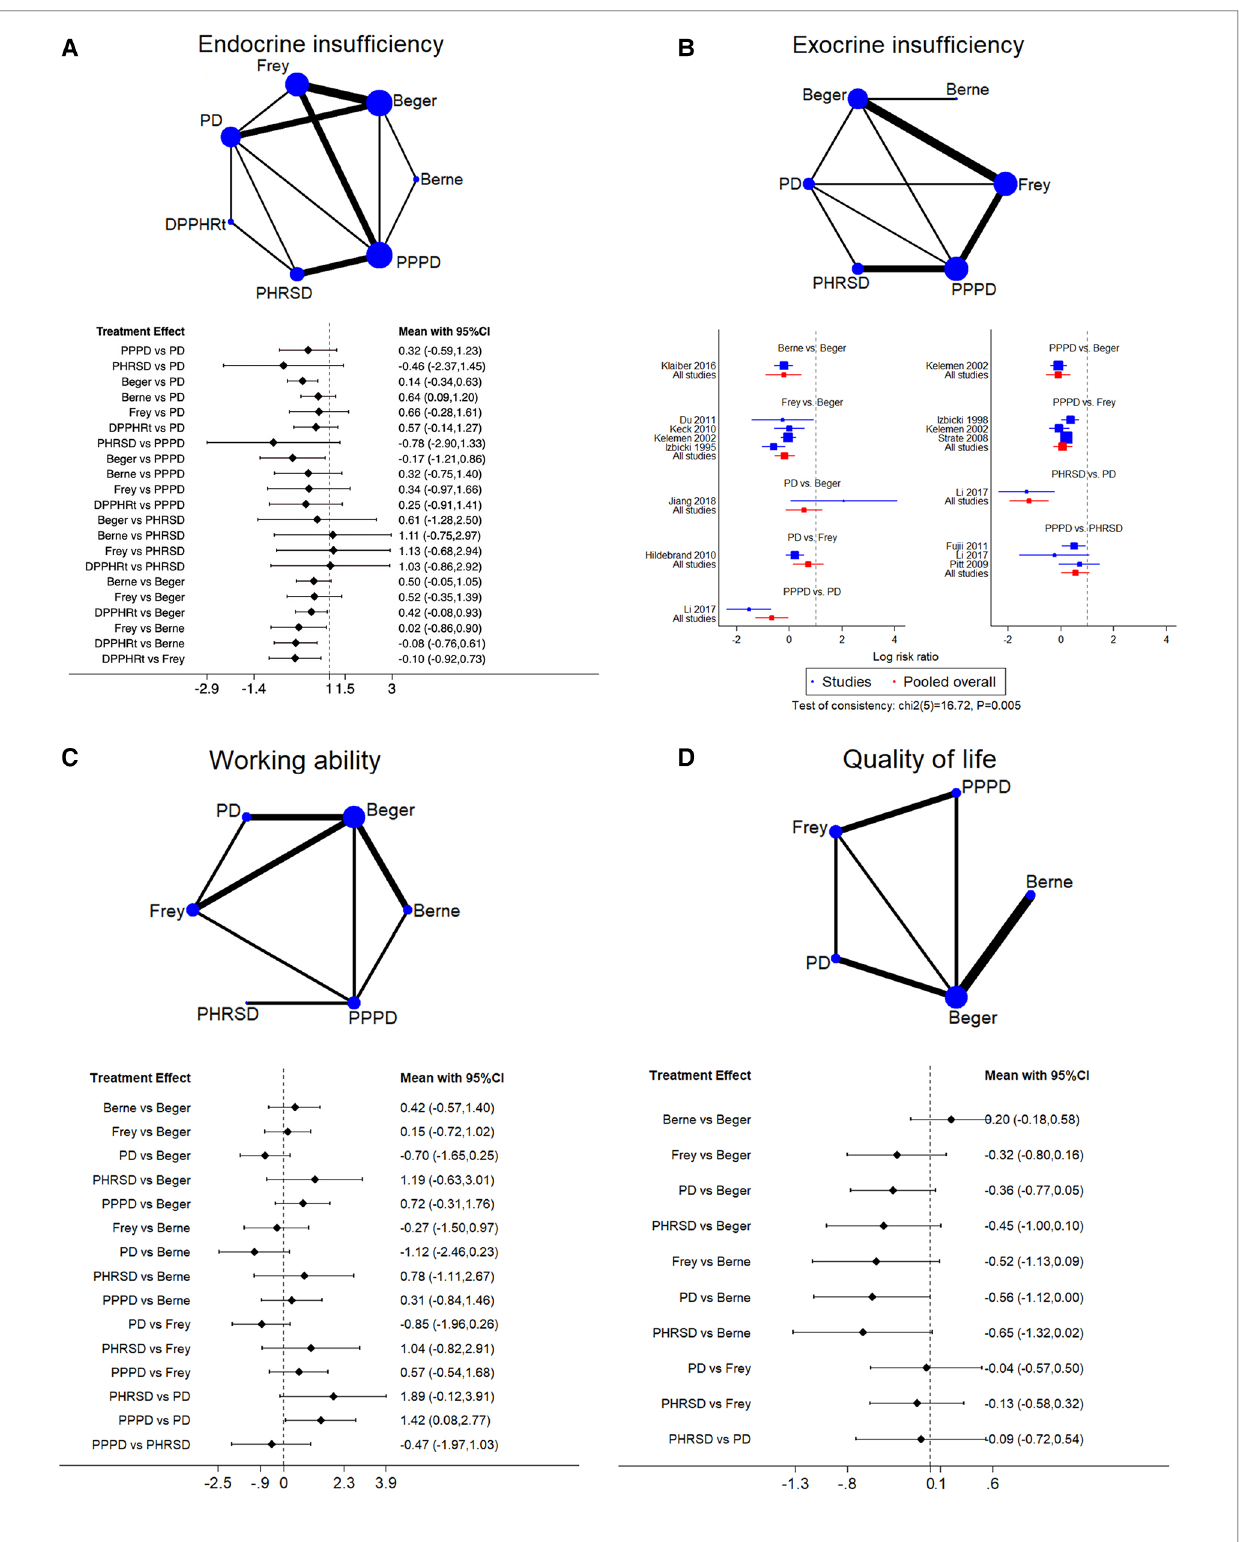
FIGURE 4 Network meta-analysis. ( A ) Endocrine insuf fi ciency, ( B ) exocrine insuf fi ciency, ( C ) working ability, and ( D ) qualify of